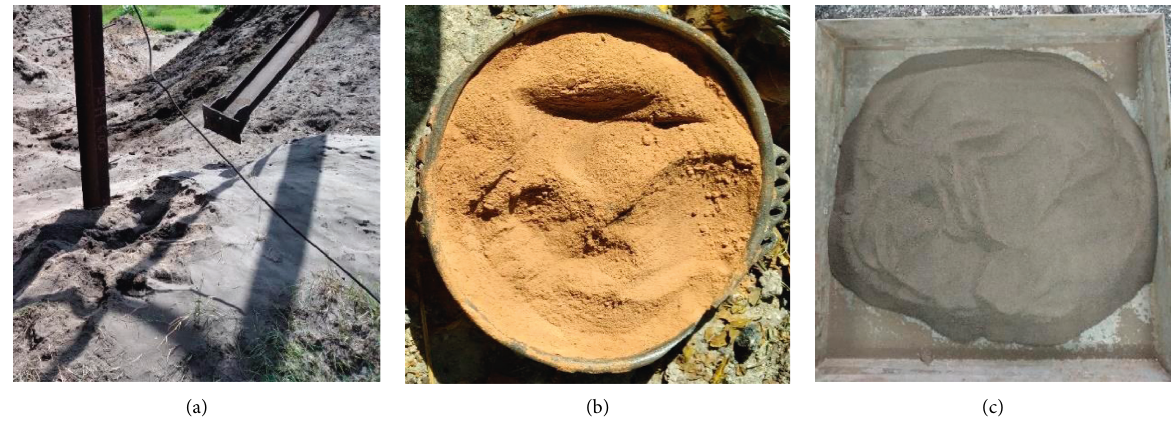
Figure 1: Materials utilized in the study: (a) BA, (b) CTCP, and (c) soil. Table 1: Laboratory tests conducted for the study. Laboratory tests